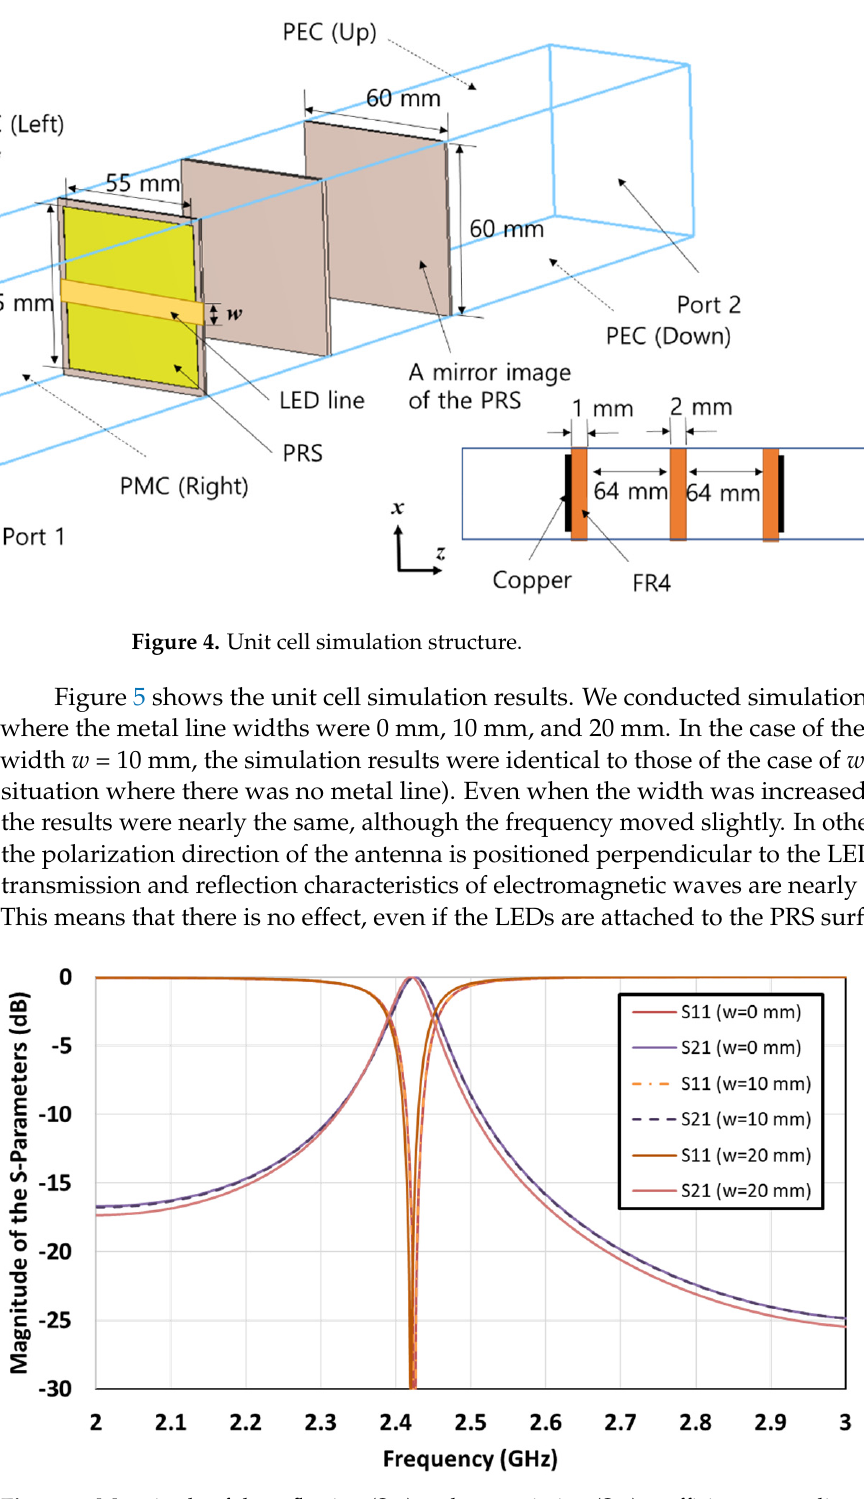
Figure 4. Unit cell simulation structure.